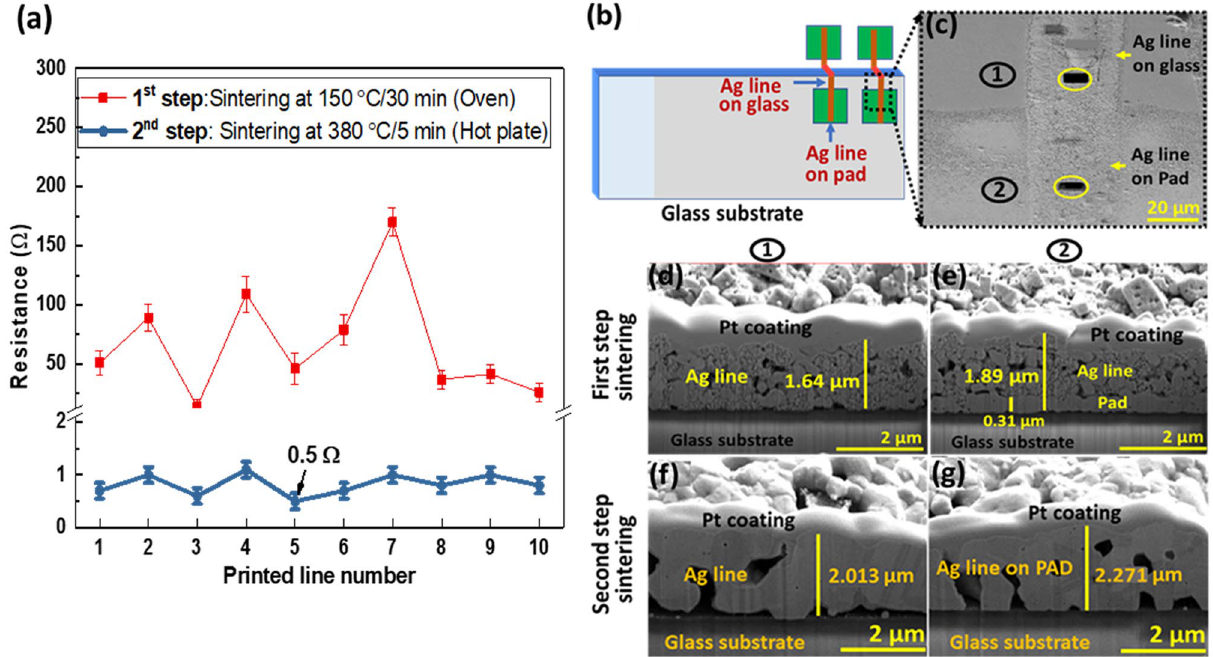
Figure 7. The resistance of printed lines and microscopic images of thermally sintered lines. ( a ) Measured resistances of printed lines. ( b ) Measurement locations of microscopic analysis. ( c ) FIB analysis locations. ( d , e ) Cross-sectional (FIB) images after first step sintering (150 °C/30 min) at locations (1) and (2). ( f , g ) Cross- sectional (FIB) images after second step sintering (380 °C/5 min) at locations (1) and